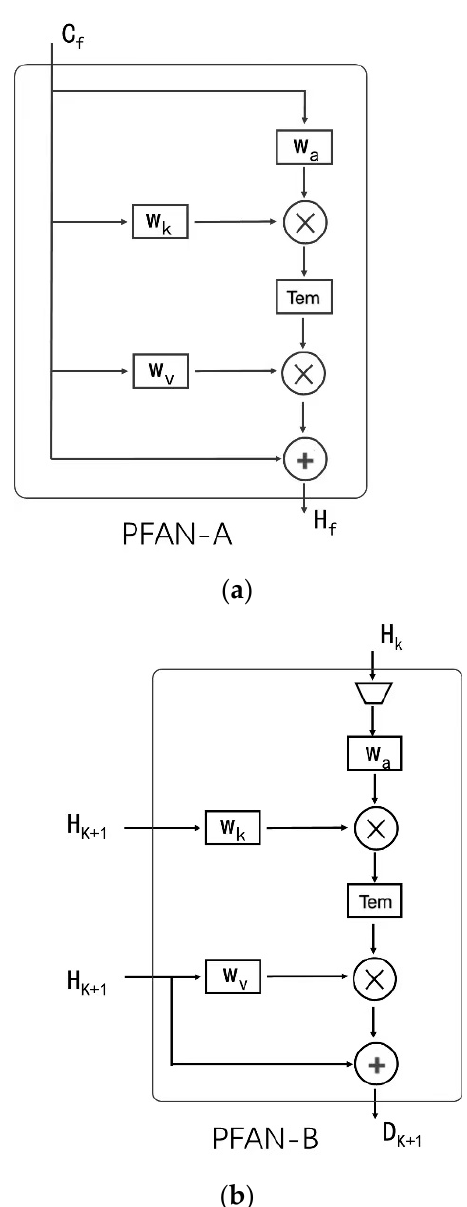
Figure 4. ( a ) PFAN-A block “ ” denotes scaled matrix multiplication. “ ” denotes element-wise sum W k , W v , and W q . are 1 × 1 Convs with zero padding and the stride of 1. Tem denotes the scaled dot operation output. ( b ) PFAN-B block, “ ” denotes the down-sample operation, imple- mented by 2 × 2 MaxPooling.